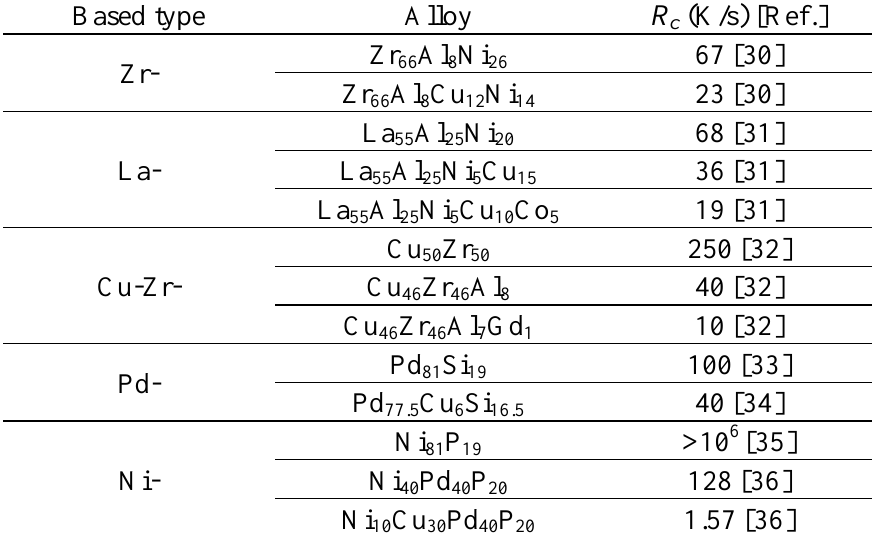
for the selected bulk metallic glasses c